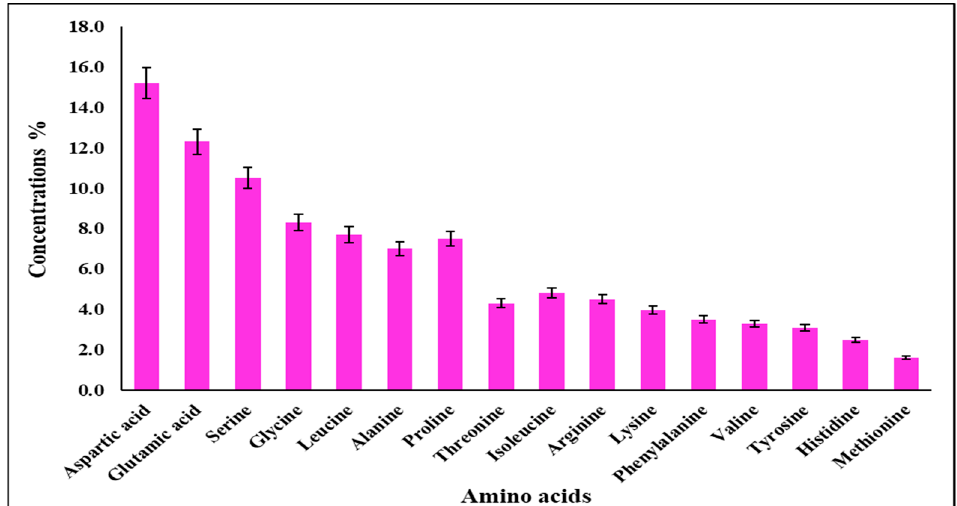
Figure 8. Amino acid composition of purified chitinase from T. funiculosus strain CBS 129594. The values are the means of three replicates with standard deviation (±SD).